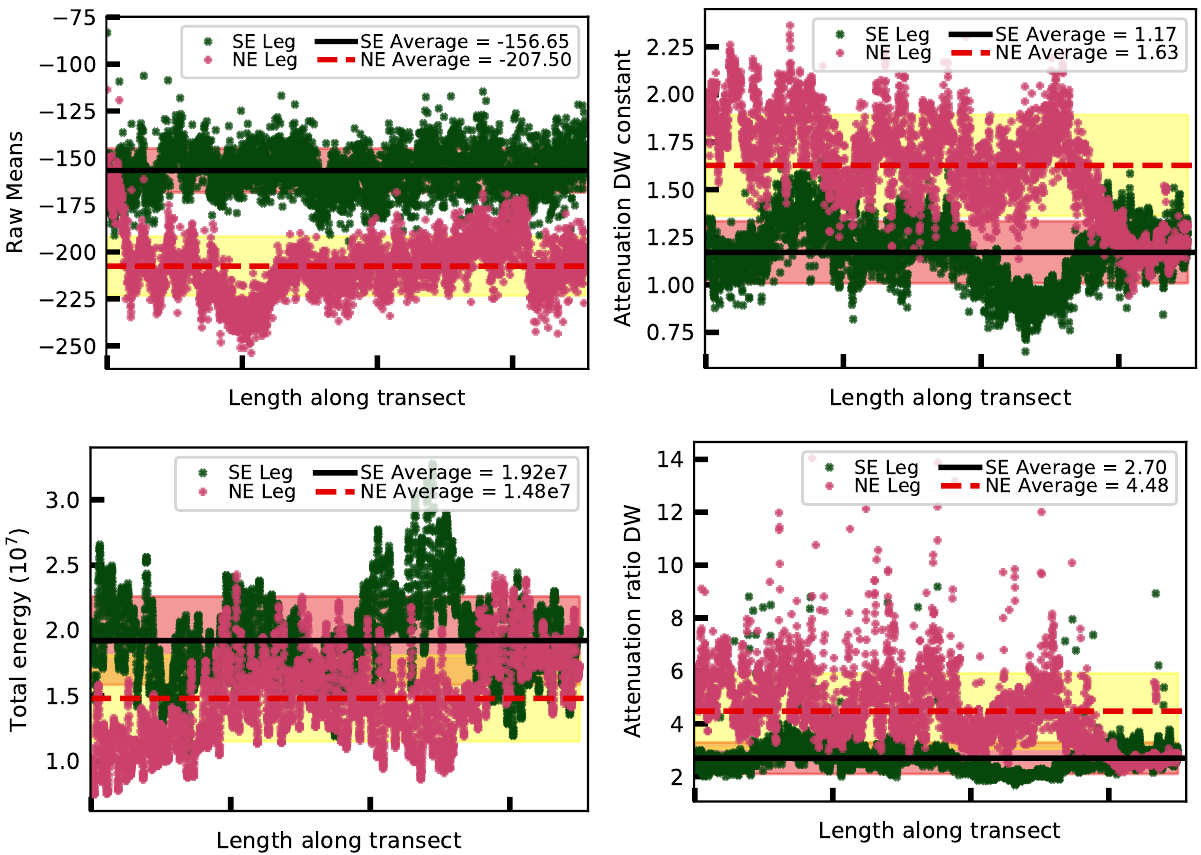
Figure 11. Attributes capturing qualitative differences in the two construction phases. The red and yellow bands around the average value of attributes represent one standard deviation range. For the first set of attributes in Figure 11, there is little or